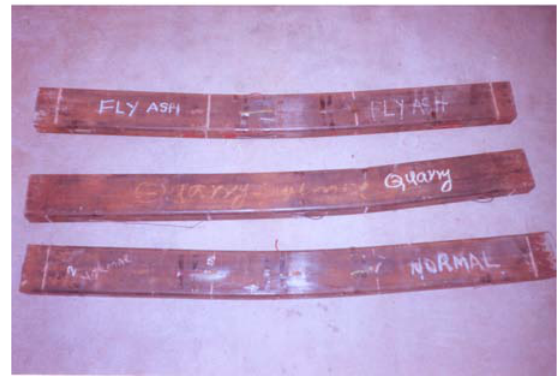
Fig. 4. Failure mode shape